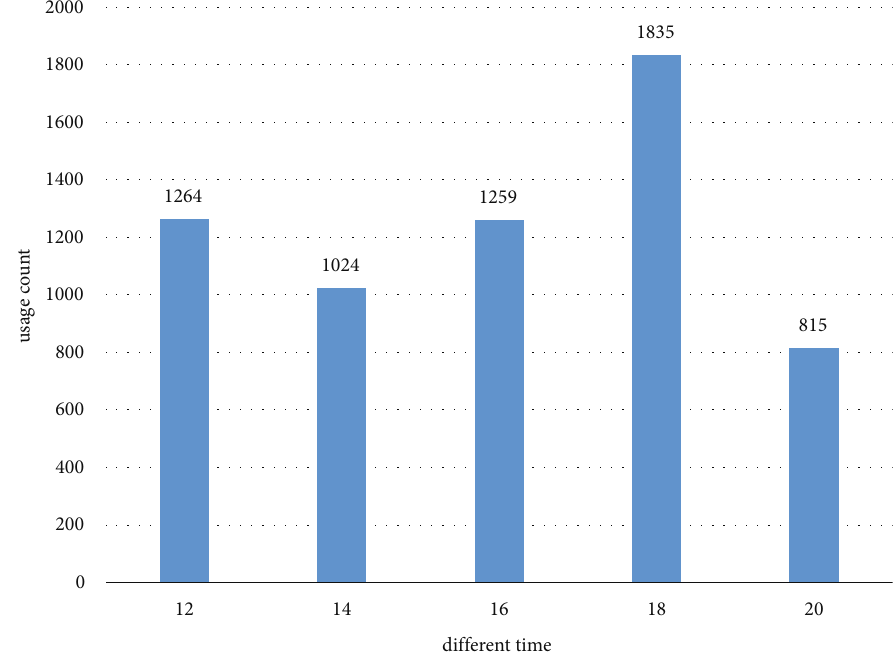
Figure 8: The number of times users use the smart payment screen in di ff erent time periods.